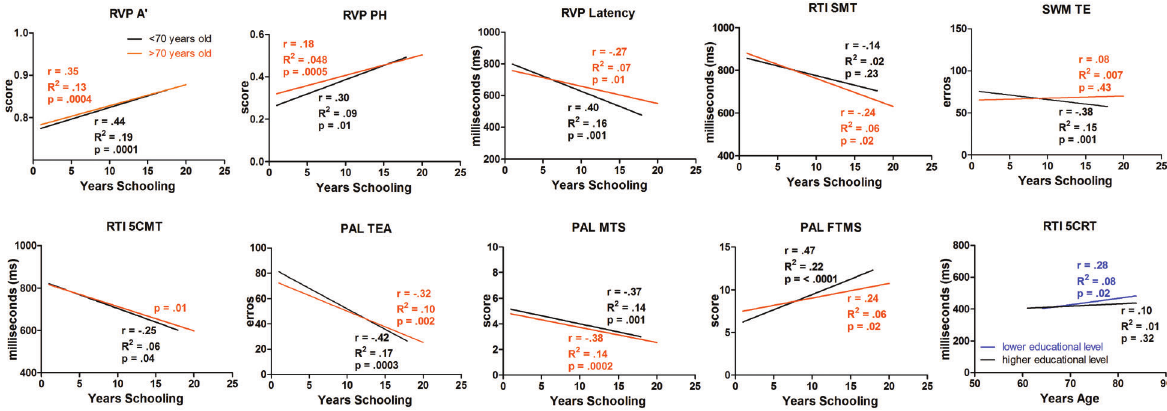
Figure 2. Cognitive performances in different tests as a function of years of schooling. Black lines represent o 70 years old subjects and orange lines represent X 70 years old subjects. Correlation (r) and regression (R 2 ) indices and P values are shown for each test and group. RVP: Rapid Visual Information Processing; RVP PH: RVP Probability of Hit; RTI: Reaction Time; RTI SMT: RTI simple movement time; SWM: Spatial Working Memory; SWM TE: SWM total error; RTI 5CMT: RTI fi ve-choice movement time; PAL: Paired Associates Learning; PAL TEA: PAL total errors adjusted; PAL MTS: PAL mean trials to success; PAL FTMS: PAL fi rst trial memory score; RTI 5CRT: RTI fi ve-choice reaction